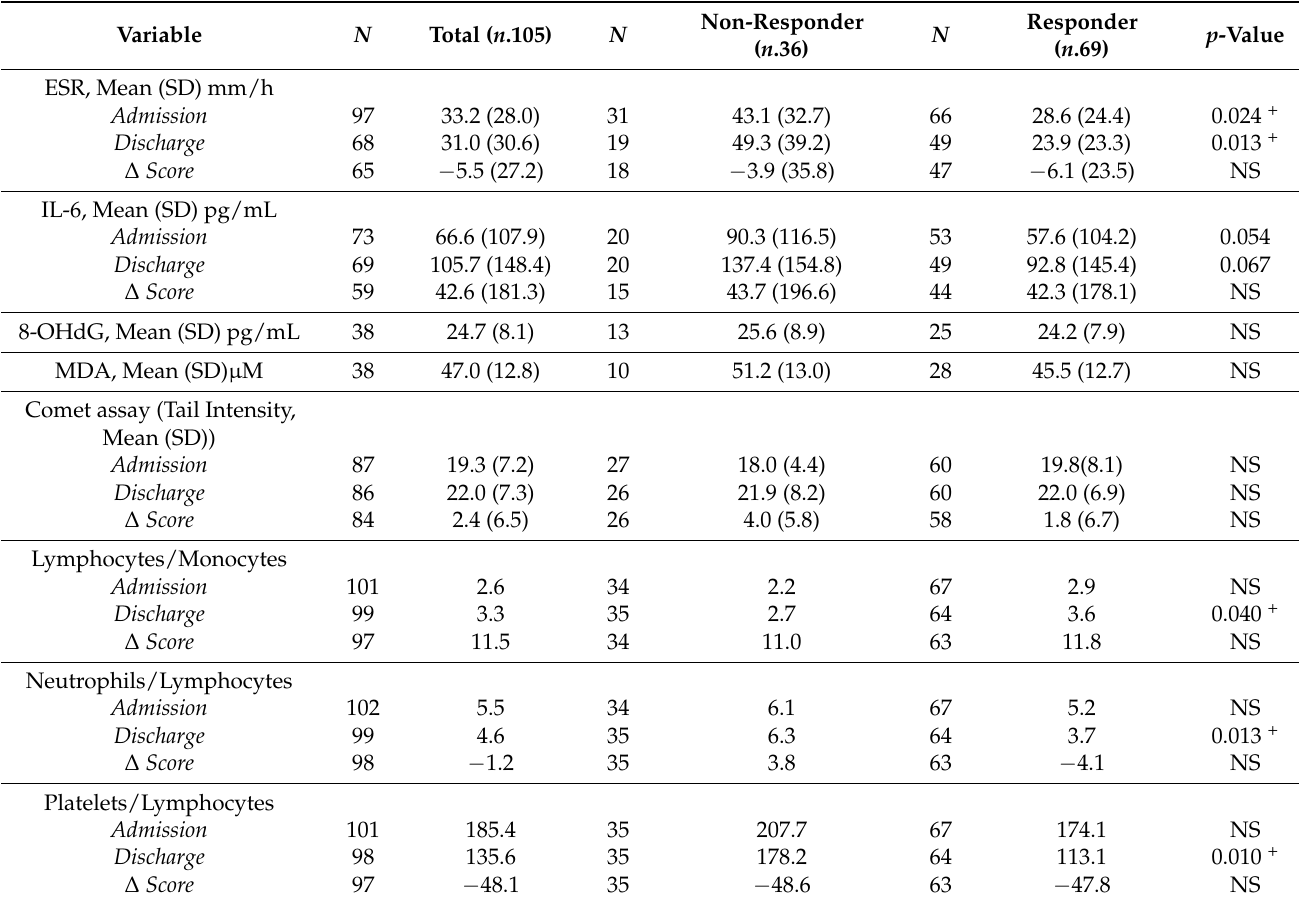
Table 3. Biomarkers of oxidative stress, inflammation and DNA damage in COPD patients by response to the treatment.